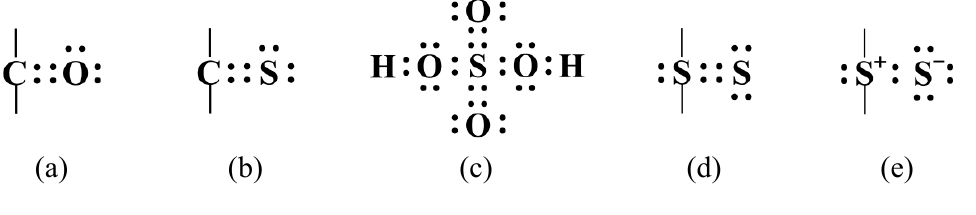
Figure 2. Sulfur bonding showing electron